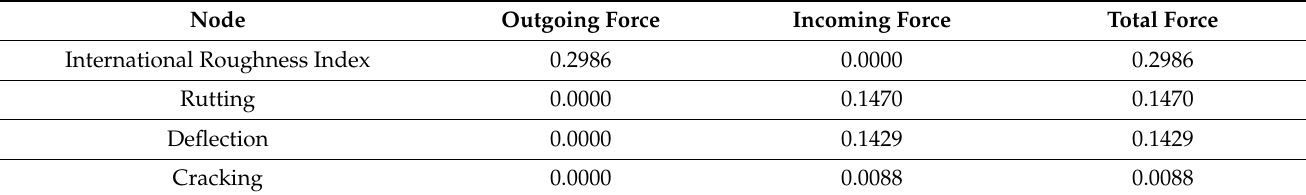
Table 6. Ranking of distress parameters based on Node